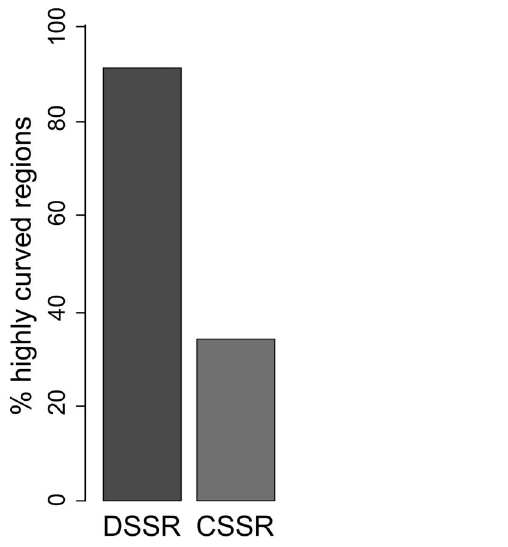
Figure 2. Regional Integrated Intrinsic Curvature analysis in L. major . Bar plot showing the percentage of regions with significant RIIC score (p , 0.05), indicated as highly curved, for divergent (DSSR) and convergent (CSSR) strand switch regions.